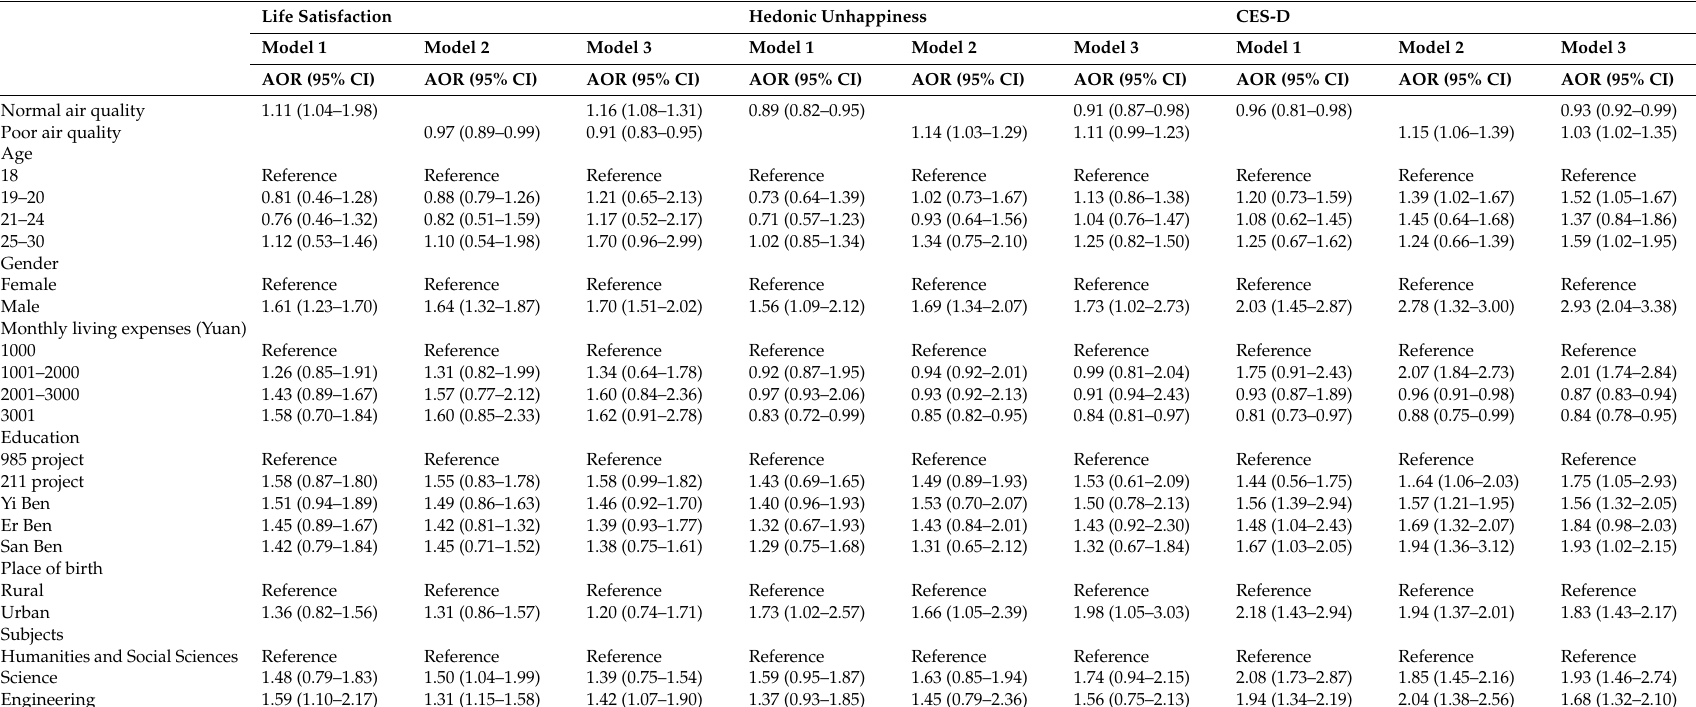
Table 4. Multivariable associations of psychological well-being operationalised in